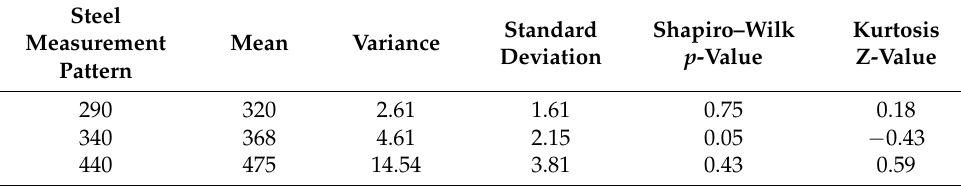
Figure 14. The normal distribution function of VL53L1X for tests with ambient light. Table 4. Statistical analysis of VL53L0X for tests with ambient Table 6. Statistical analysis of VL53L1X for tests with ambient light.